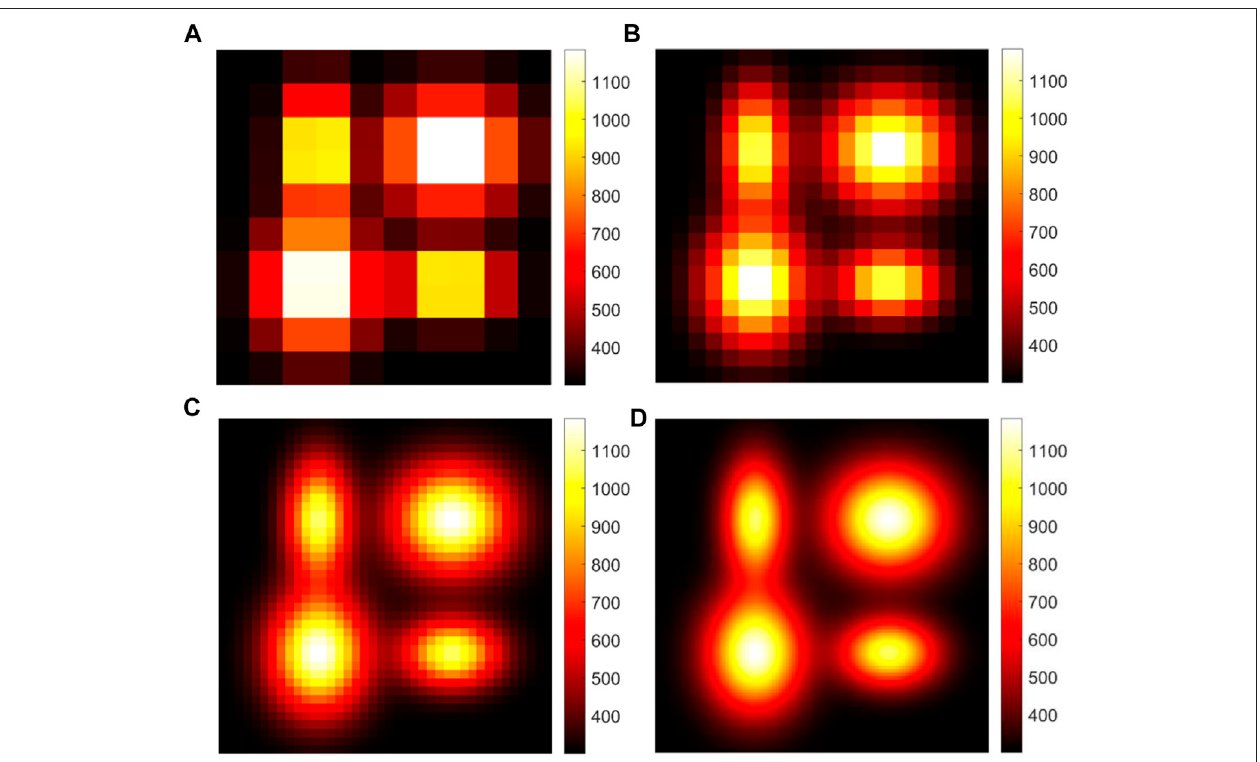
FIGURE 8 | The temperature distribution under different grids (A) 10 × 10, (B) 20 × 20, (C) 40 × 40, and (D) 80 × 80.